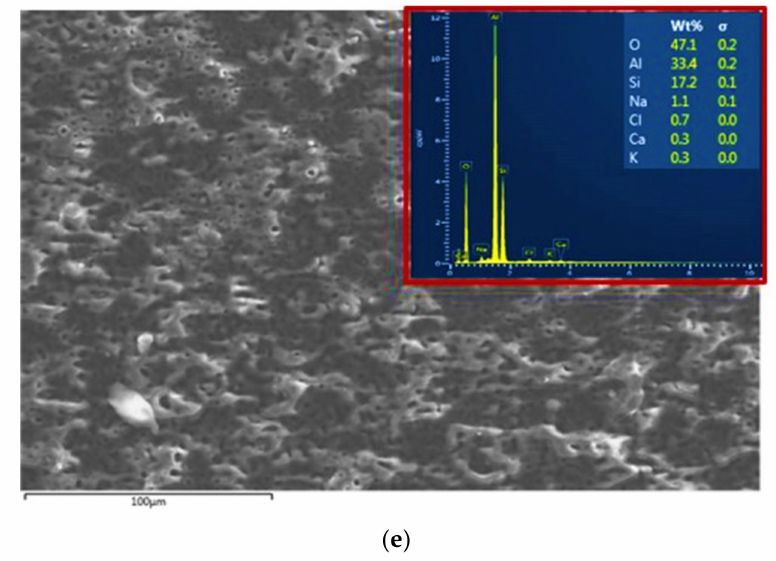
Figure 2. EDS analysis of the AA2014 Al alloy samples after PEO coating under different conditions: